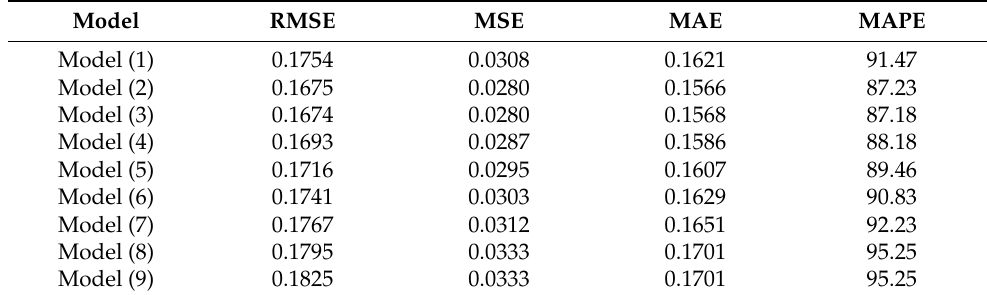
Table 6. Evaluation the level of uncertainty for bell IT2